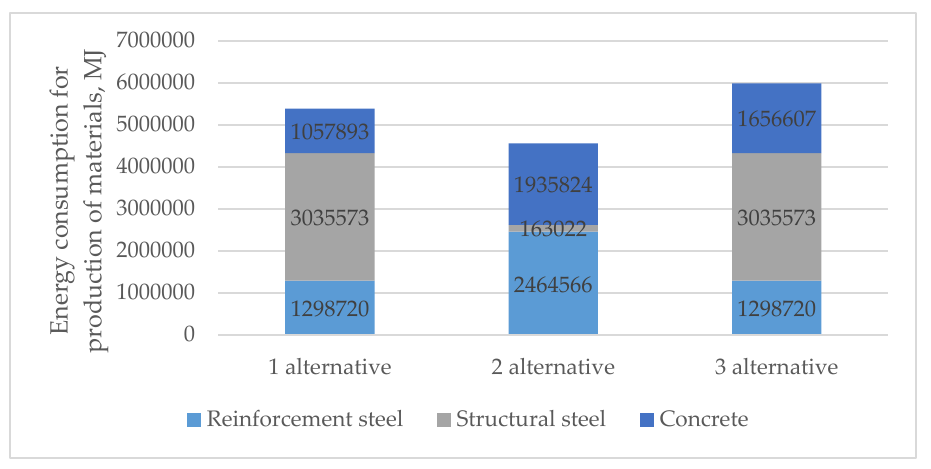
Figure 12. Comparison of energy consumption for production of materials (MJ).